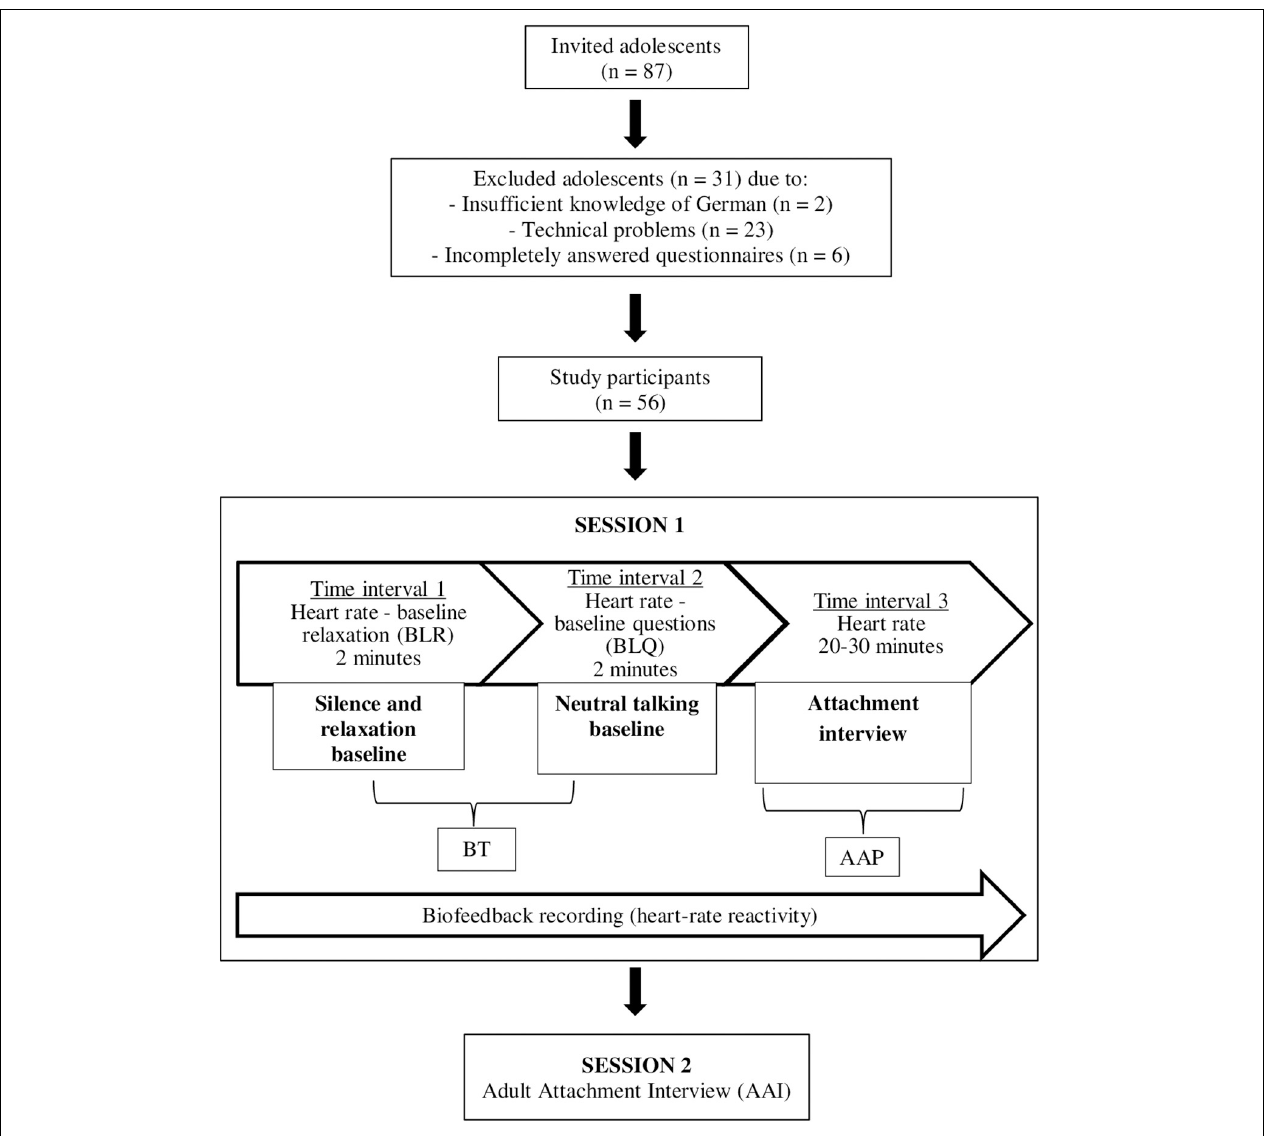
FIGURE 1 | Participant’s exclusion and inclusion criteria and graphical representation of the experimental